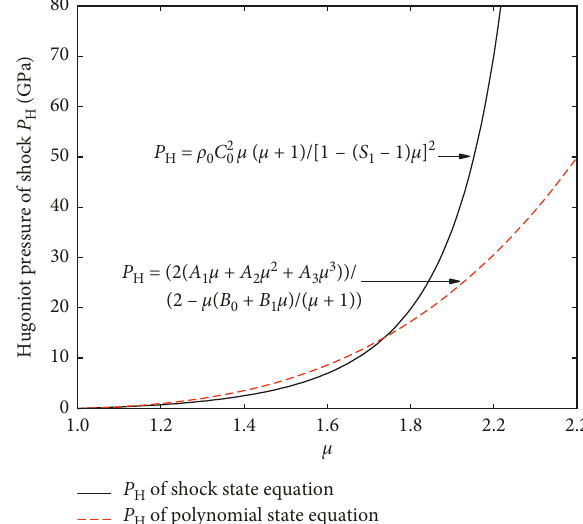
Figure 10: The relation between PH and μ under two different state equations.